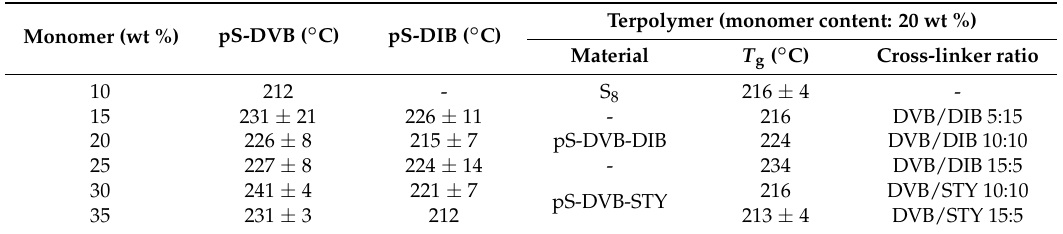
Table 1. Decomposition temperature at 5% weight loss (TGA).